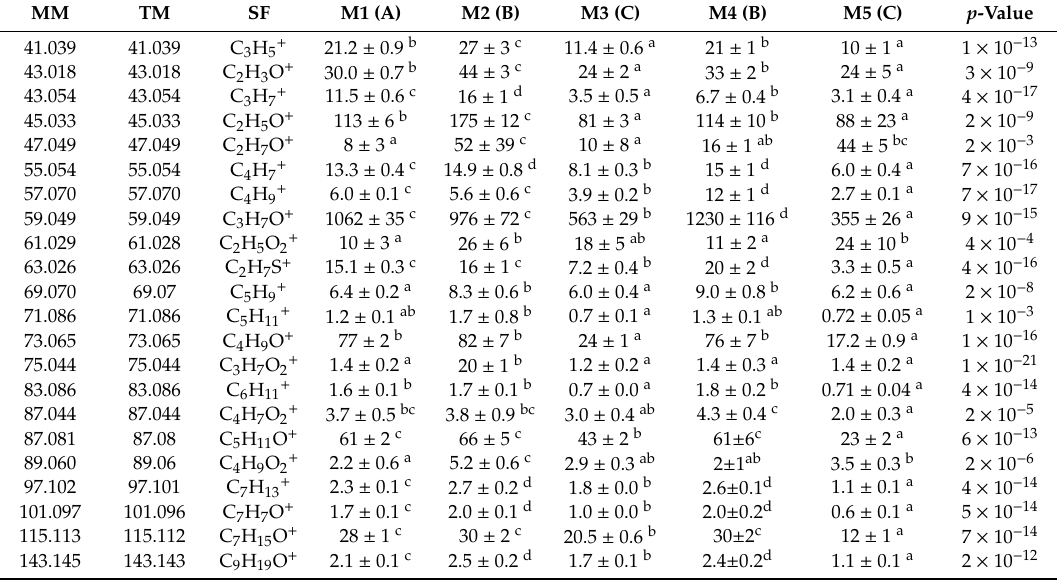
Table 3. Organic compounds associated to mascarpone headspace detected by PTR-ToF-MS. Black color indicates compounds identified also by SPME / GC-MS. For each compound, di ff erent letters indicate a significant di ff erence between di ff erent samples according to ANOVA and Tukey HSD ( p < 0.05). The codes correspond to the samples indicated in Table 1. In the parenthesis, the di ff erent